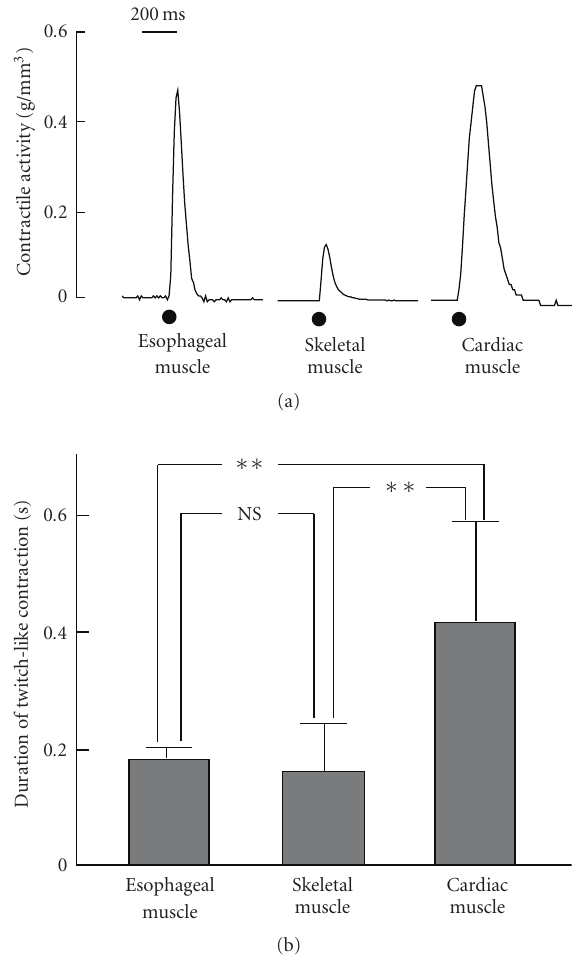
Figure 1: Single-pulse electrical stimulation-induced twitch-like contractions of esophageal, skeletal, and cardiac muscles in rats. (a) Representative traces of the contractile responses to electrical field stimulations (EFS) in esophageal, skeletal, and cardiac muscle preparations are shown. EFS was applied by using single pulses (voltage: 80 V, duration: 10ms). Closed circles indicate the points of EFS. (b) Summary graphs of the duration of the EFS-evoked twitch-like contractions in esophageal ( n = 16), skeletal ( n = 6), and cardiac ( n = 5) muscle preparations. Each bar represents the mean ± S.D. ∗∗ shows significant di ff erence ( P < . 01). NS shows no significant di ff